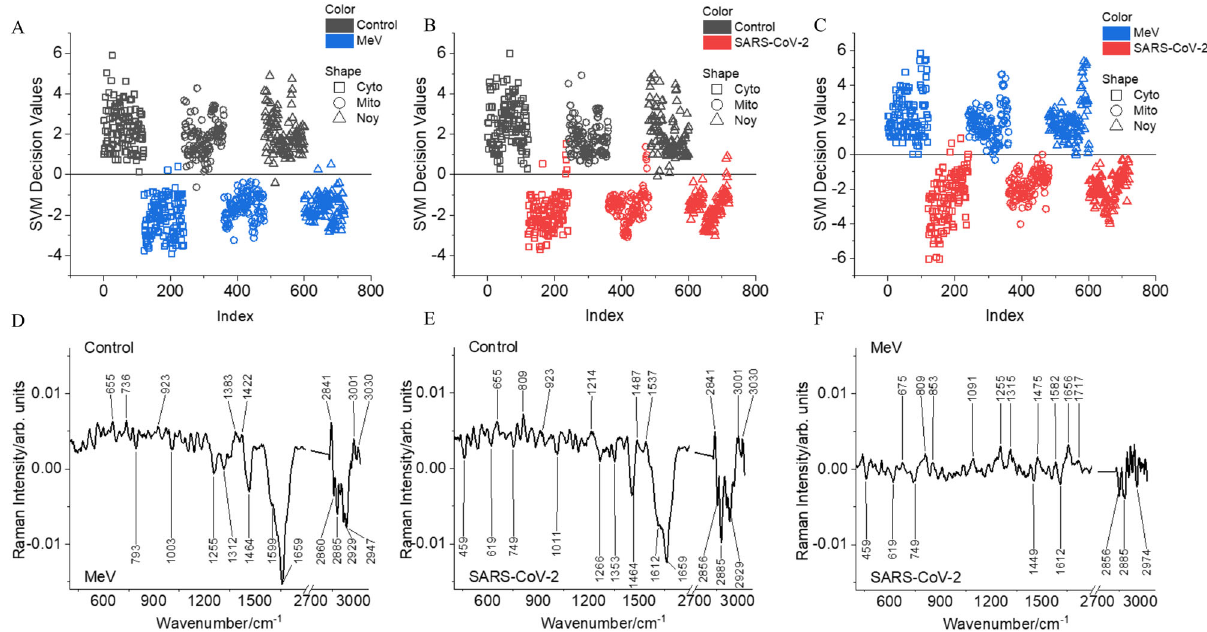
Fig. 4 Raman model generated using support vector machine (SVM) algorithm to differentiate. A noninfected (Control, black) from measles virus (MeV, blue) infected Vero E6 cells, B noninfected (Control, black) from SARS-CoV-2 (red) infected Vero E6 cells, and C MeV and SARS-CoV-2-infected Vero E6 cells. The model was generated using Raman spectra extracted from intracellular components: cytoplasm (Cyto, square), Golgi-mitochondria bodies (Mito, circle), and nucleus (Noy, triangle) of the Vero E6 cells (Total accuracy A 98.89%, B 97.22%, C 97.78%, PCs used 13, tenfold CV other parameters same as below). The difference Raman spectra calculated between D control minus measles virus (MeV), E control minus SARS-CoV-2, and F Measles (MeV) minus